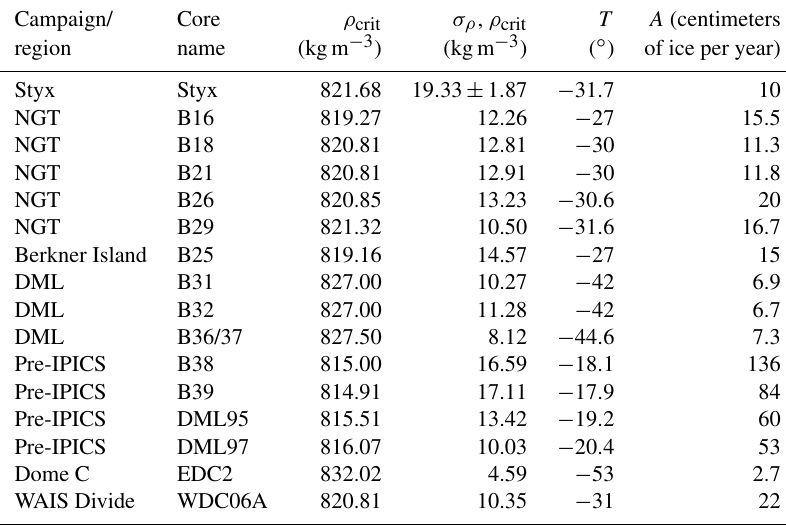
Table 2. Comparison of standard deviation of density ( σ ρ ) at critical density ( ρ crit ). For data from all other sites, except Styx, refer to Hörhold et al.